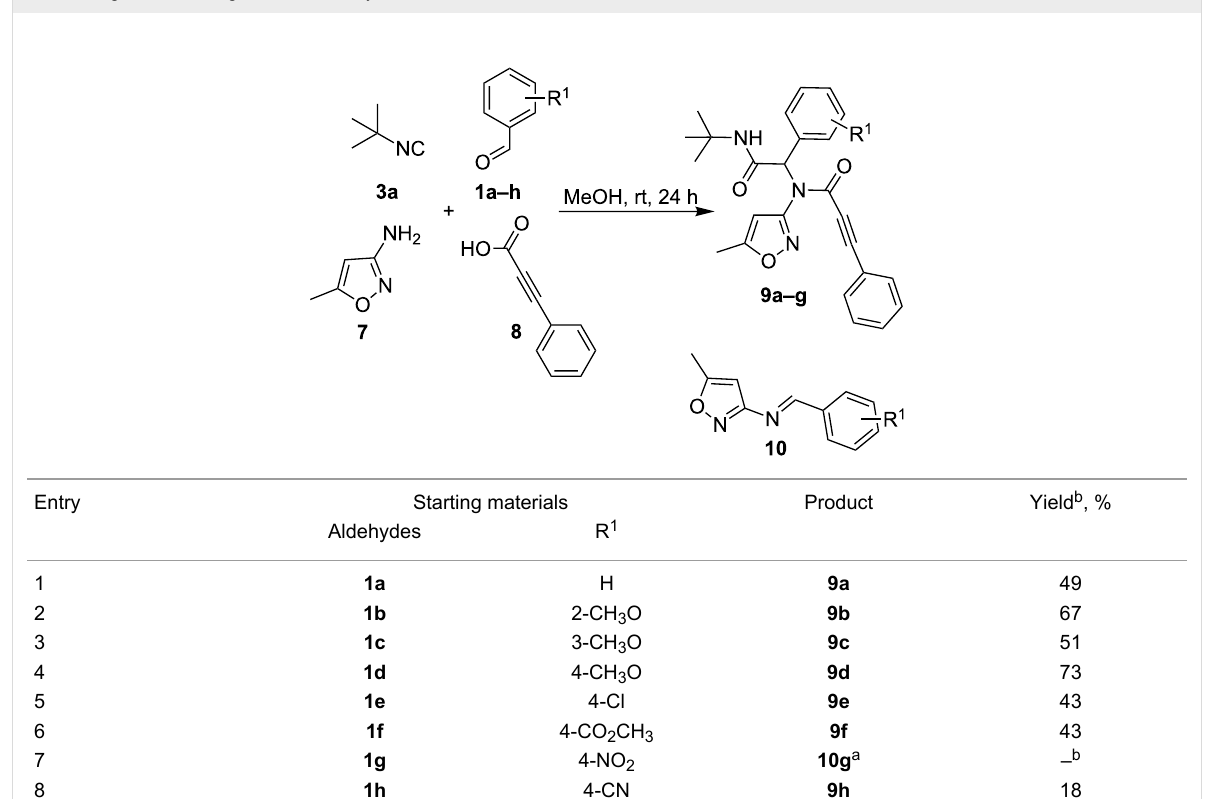
Table 6: Ugi-4CR involving